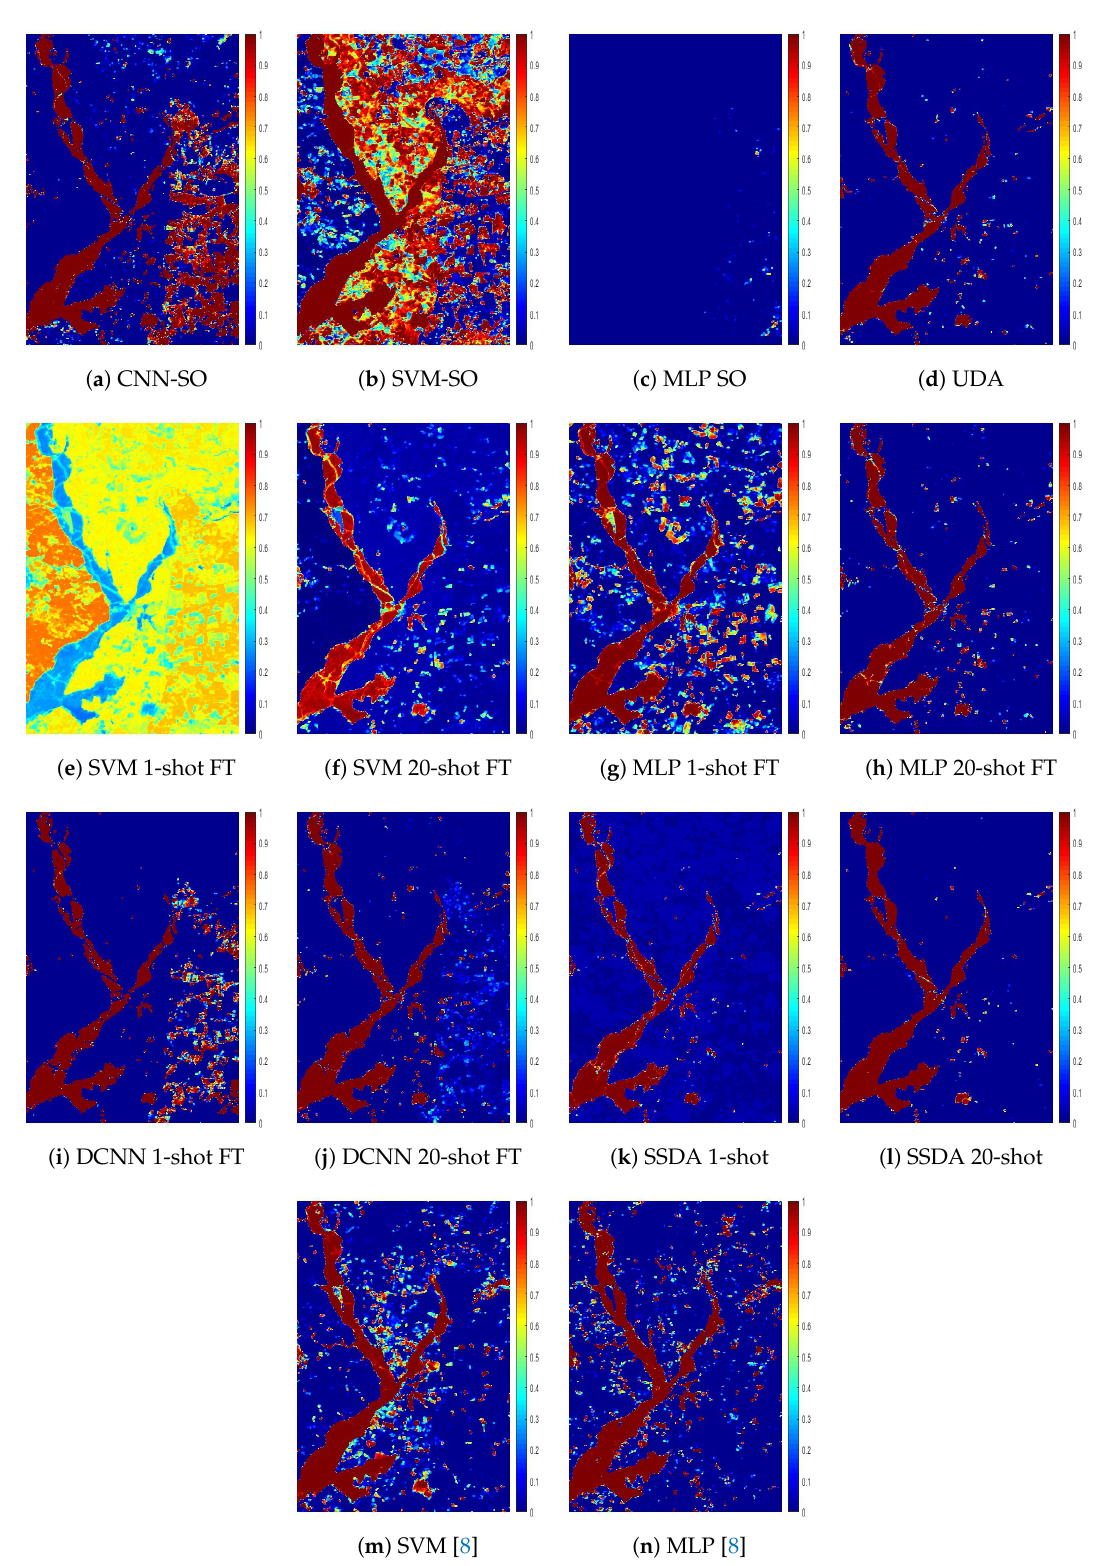
Figure 9. Output after morphological operation with disk structures (MO-DS) on the OPPs. Blue represents the probability ‘0’ and Red represents probability